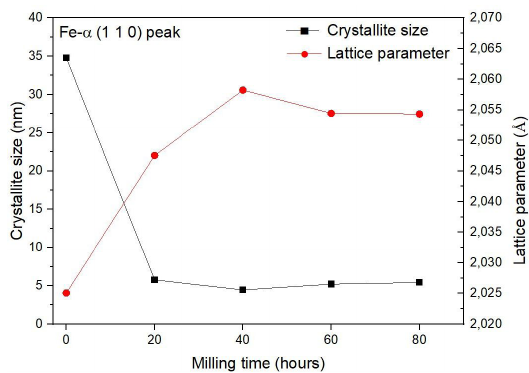
Figure 9. Crystallite size and lattice parameter as a function of different milling times for the (110) Fe-α peak for Fe-15at.%Nb samples without PCA (reference).